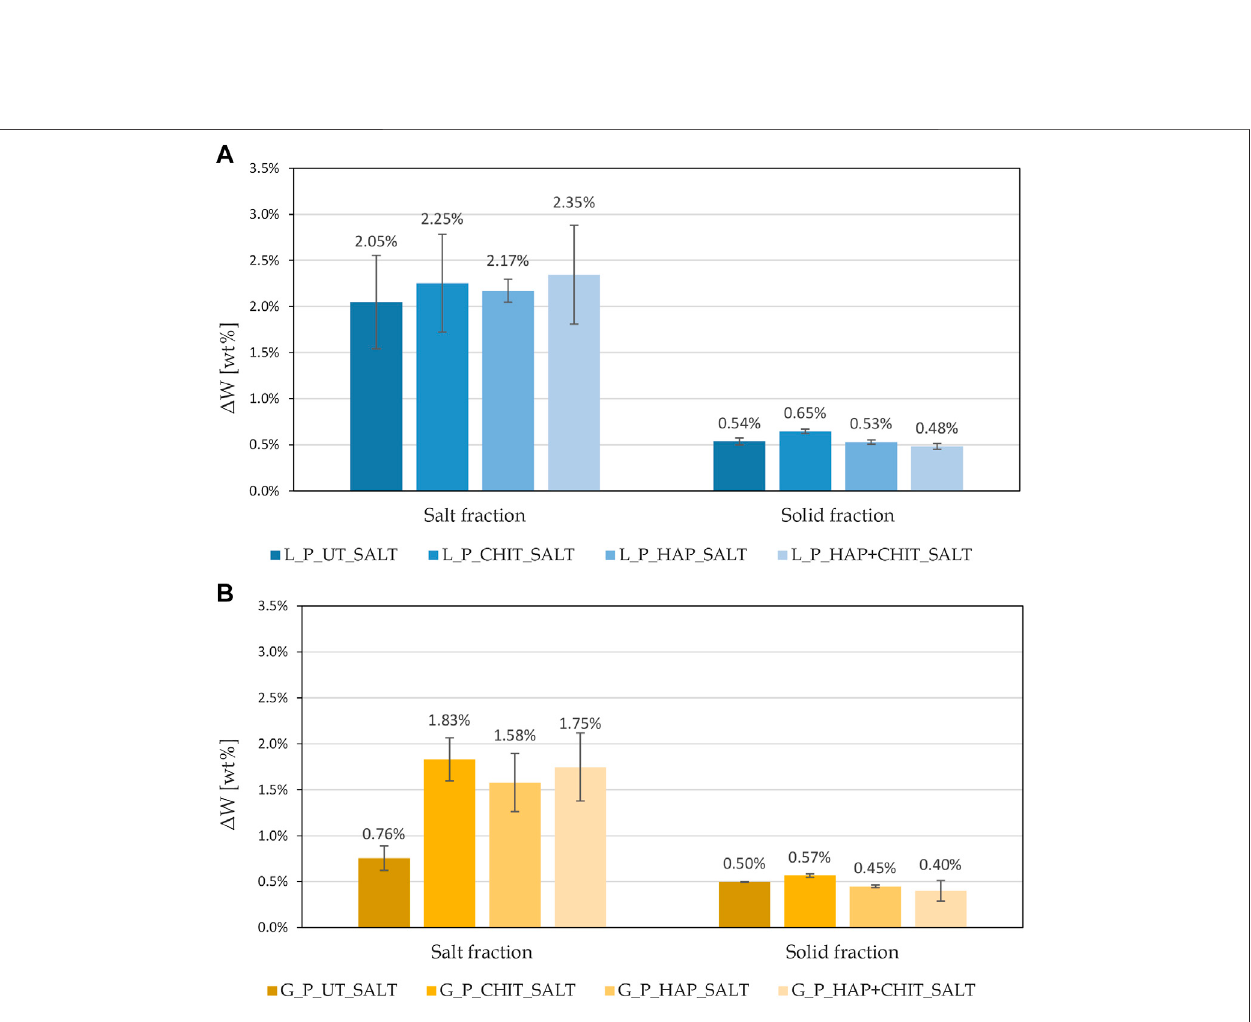
Frontiers in Materials |